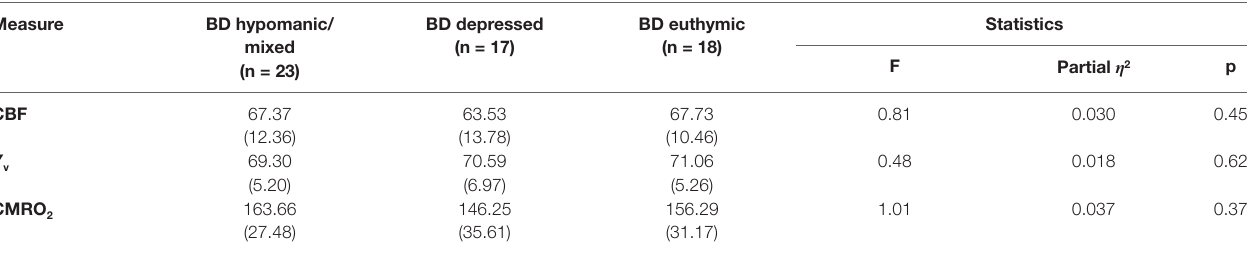
TABLE 2 | CBF, Y v , and CMRO 2 across mood states.